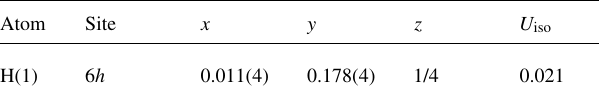
Table 2. Atomic coordinates and displacement parameters (in Å 2 )